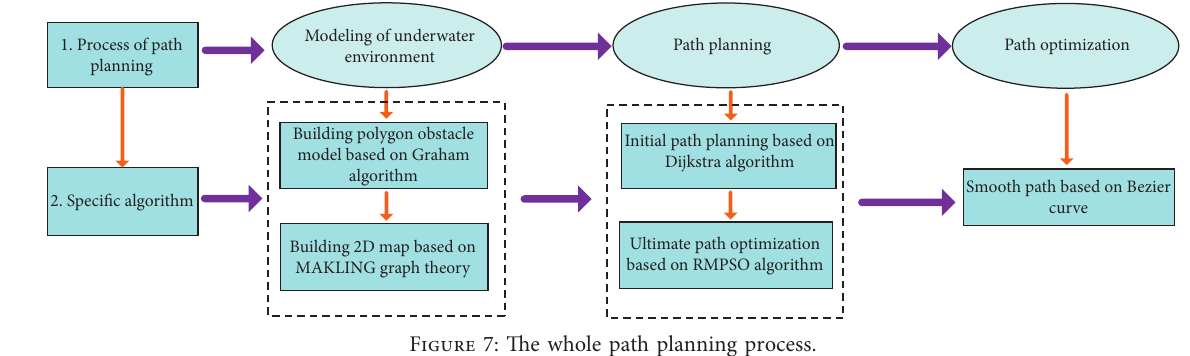
Figure 7: The whole path planning process.